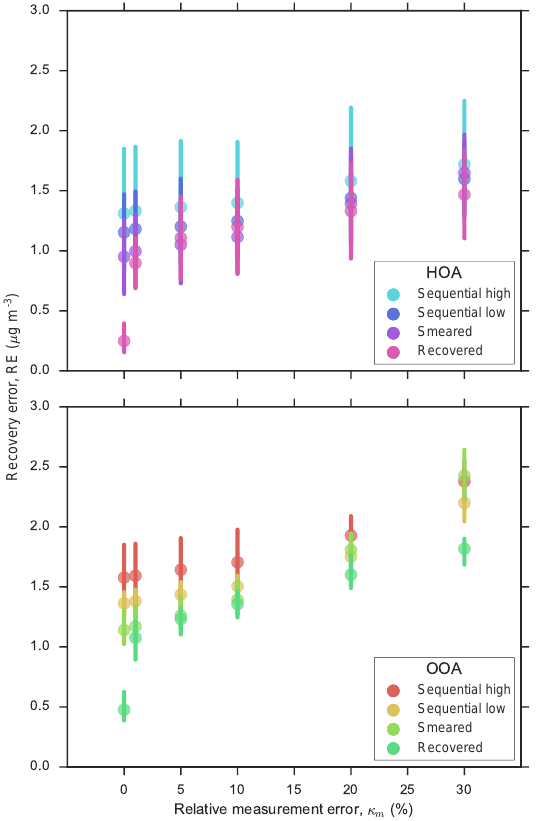
Figure 10. Mean recovery error (RE) against relative measure- ment error for HOA and OOA time series processed by the se- quential, smeared and recovered methods. T = 57h and (cid:49)τ = 4h. The “sequential high” and “sequential low” time series are con- structed by linear interpolation between suboptimally and optimally scheduled sequential measurements, respectively. The recovered so- lutions were obtained with TSVD regularization and the truncated boundary method.